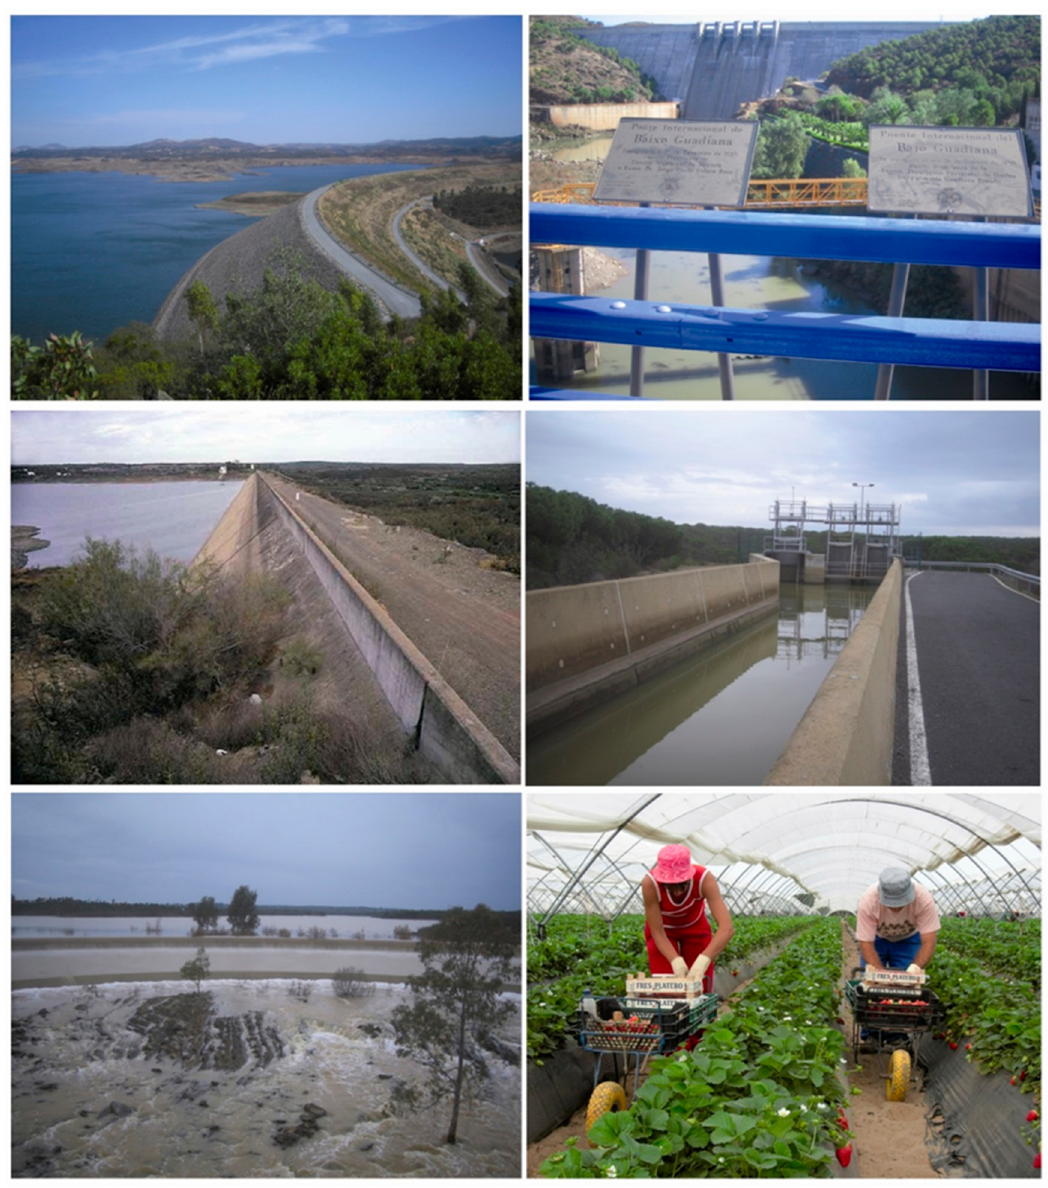
Figure 4. Hydraulic infrastructures of the Andévalo–Chanza–Piedras–Machos System and strawberry fields in Huelva. (Source: [52,53]).